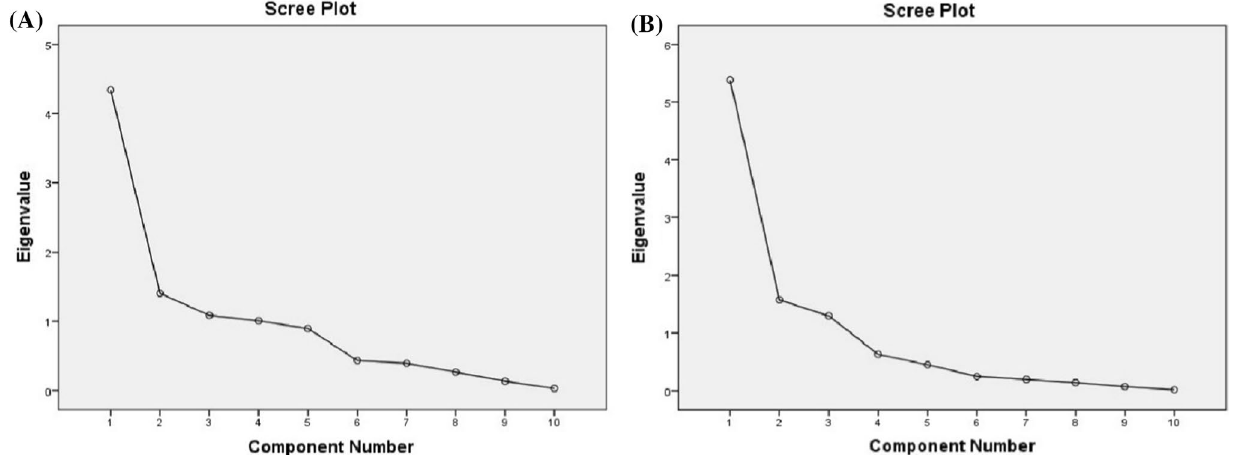
Fig. 4 Scree plot of the eigenvalue for each component ( a ) confined and ( b ) unconfined